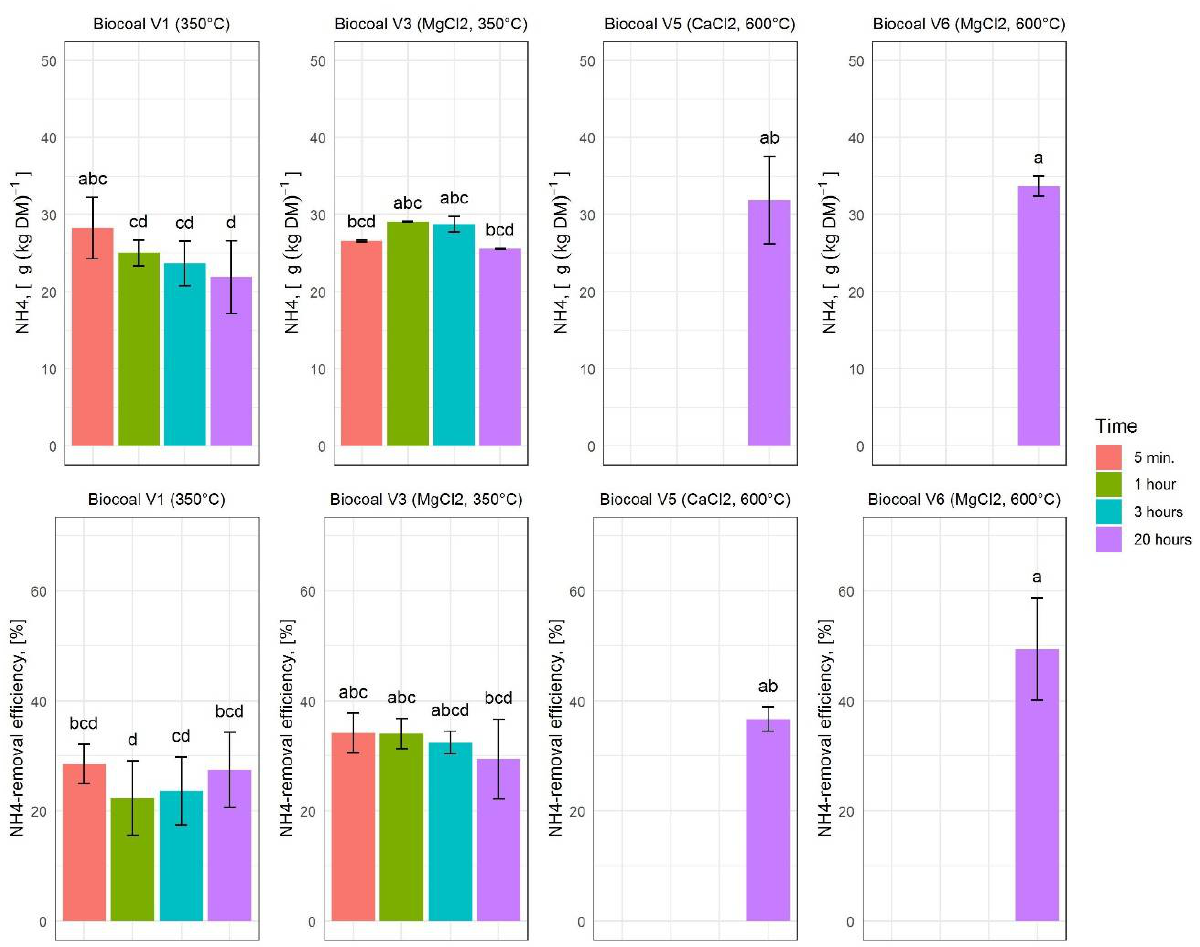
Figure 6. Ammonium (NH 4 ) concentration and NH 4 -removal efficiency for the different variants of added biocoal. The upper diagrams show the NH 4 concentration. The lower diagrams show the removal efficiency. Histograms are charted based on the mean values; error bars indicate the variability between the three replications. Lower case letters indicate significant differences according to Tukey test.